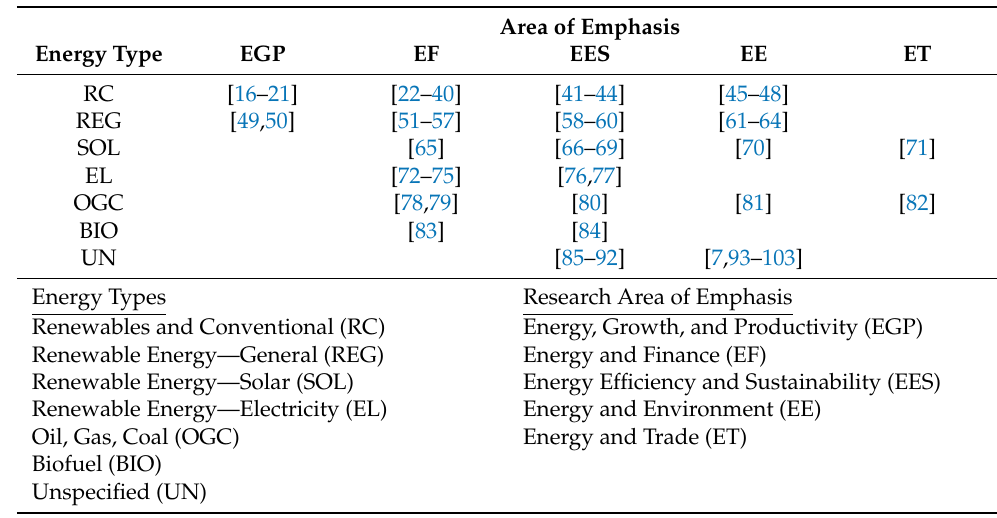
Table 4. Categorization of